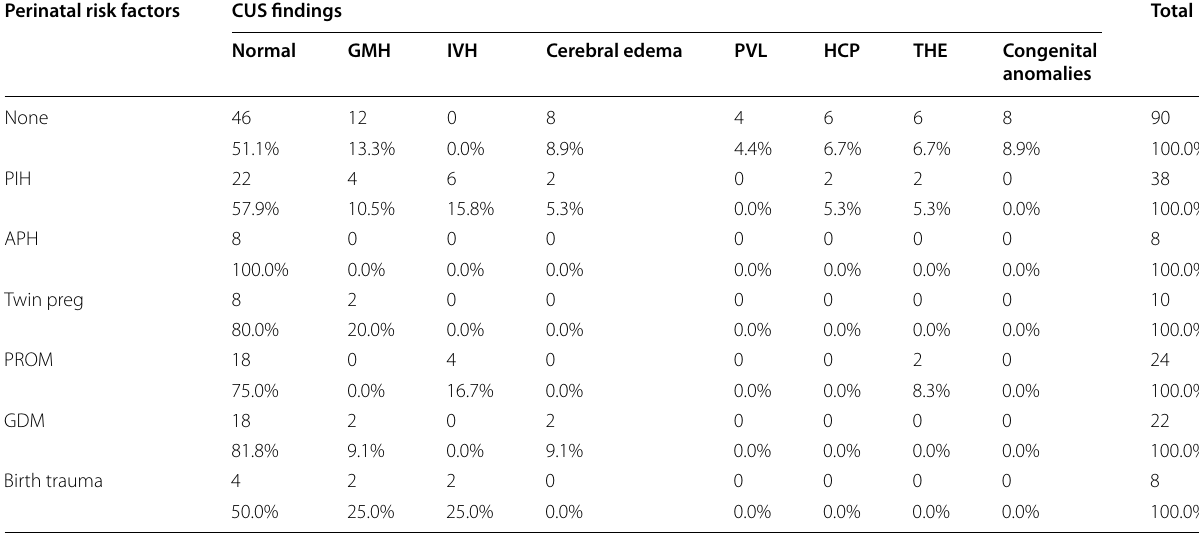
CUS cranial ultrasound, GMH germinal matrix hemorrhage, IVH intra-ventricular hemorrhage, PVL periventricular leukomalacia, HCP hydrocephalus, THE thalamic hyperechogenicity